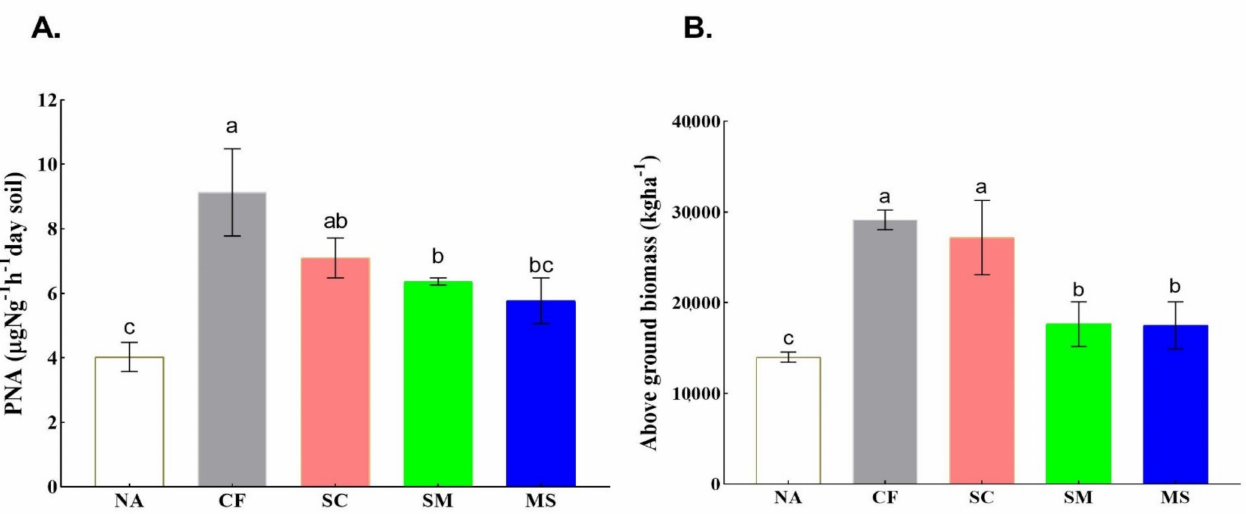
Figure 2. ( A ) Soil potential nitrification activity (PNA), and ( B ) Aboveground biomass under diverse fertilization amend- ments. Bars with different alphabets (a, b, ab, b and c) show significant difference at p < 0.05, while those with a common alphabet show no significant difference (i.e., p > 0.05). NA = no fertilizer, CF = Chemical fertilizer, SC = inorganic fertilizer plus cow manure, SM = cow manure, and MS = corn stalk. The means separation was done with the Duncan Multiple Range Test at p < 0.05. The error bars represent the standard error of means of the triplicate